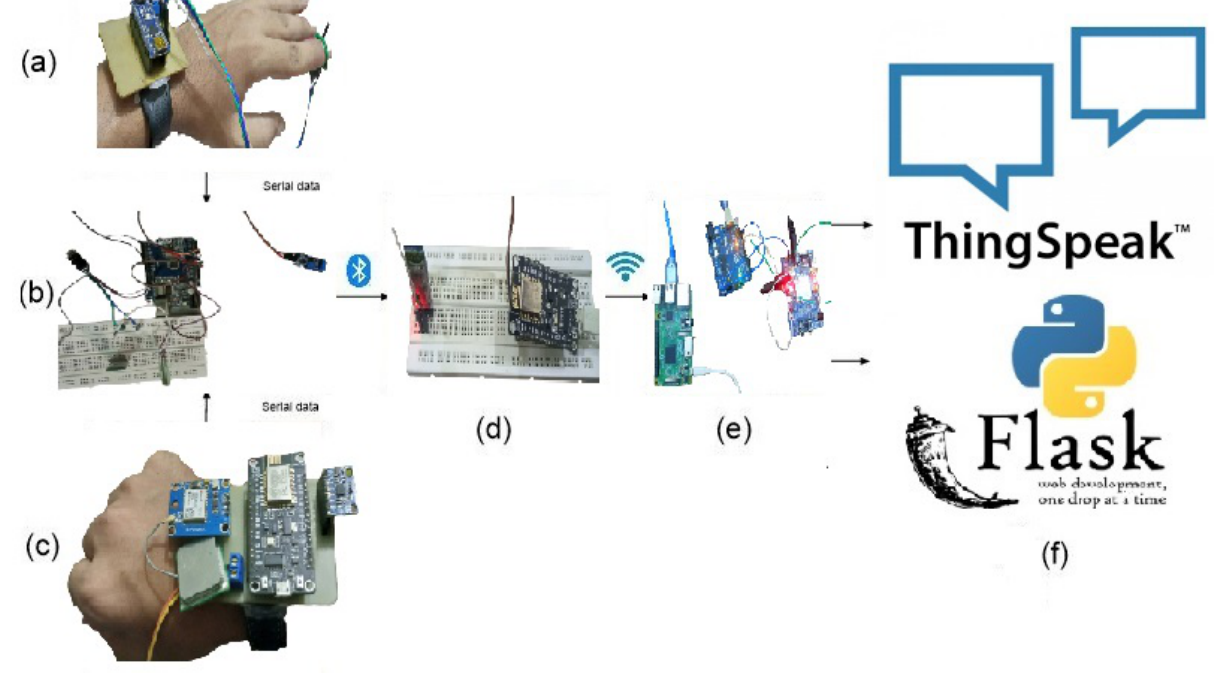
Figure 9. ( a ) Left arm dorsal (SpO 2 , Gyroscope and accelerometer sensors); ( b ) Chest (ECG, Breathing and temperature sensor, Bluetooth module (Master)); ( c ) Right arm dorsal (RSSI, Alarm status, GPS coordinates); ( d ) Gateway to centralized data (Slave for receiving data from sensors); ( e ) Centralized server for multiple patients; ( f ) Flask server for local server monitoring and ThingSpeak for remote